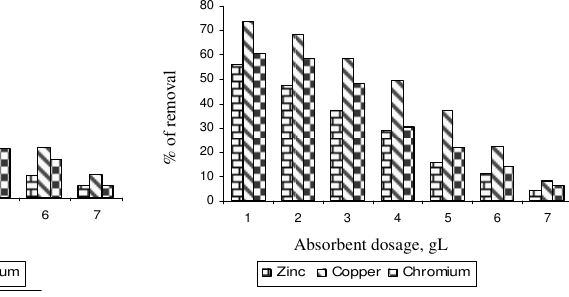
Figure 1. Effect of adsorbent dosage on the removal of of Zn(II), Cu(II) and Cr(VI) by sawdust. Condition: T = 23 o C and t = 60 minutes